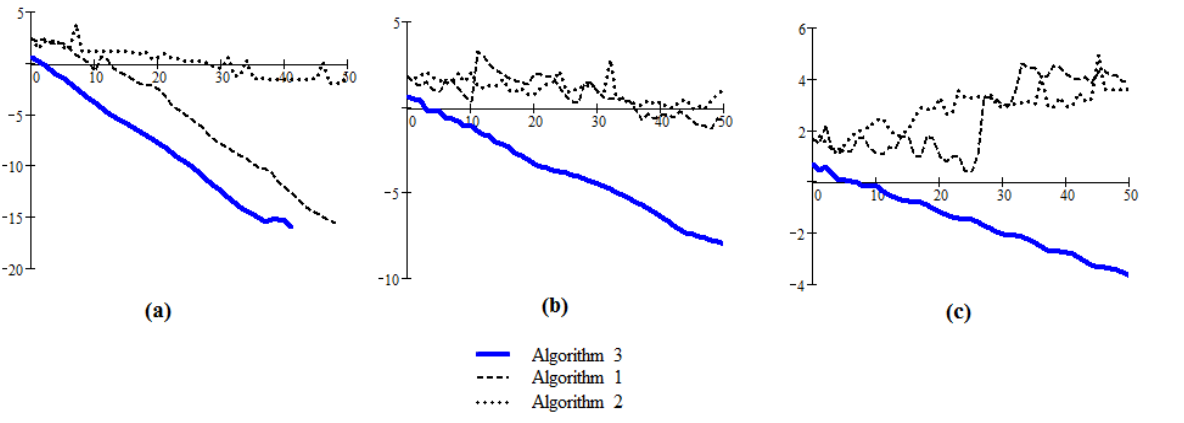
Figure 4. The comparison of Algorithms 3, 1 and 2 in the care of linear systems of low dimensions (m = 5); ( a ) condition number = 8.598; ( b ) condition number=4.624; ( c ) condition number =